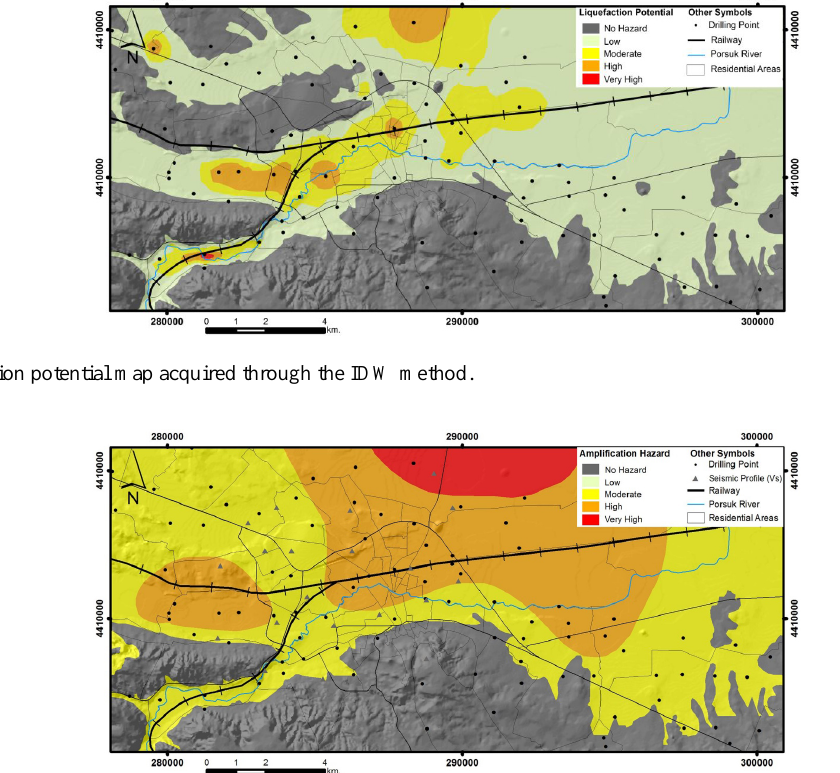
Figure 8. Amplification hazard map acquired through the IDW method.